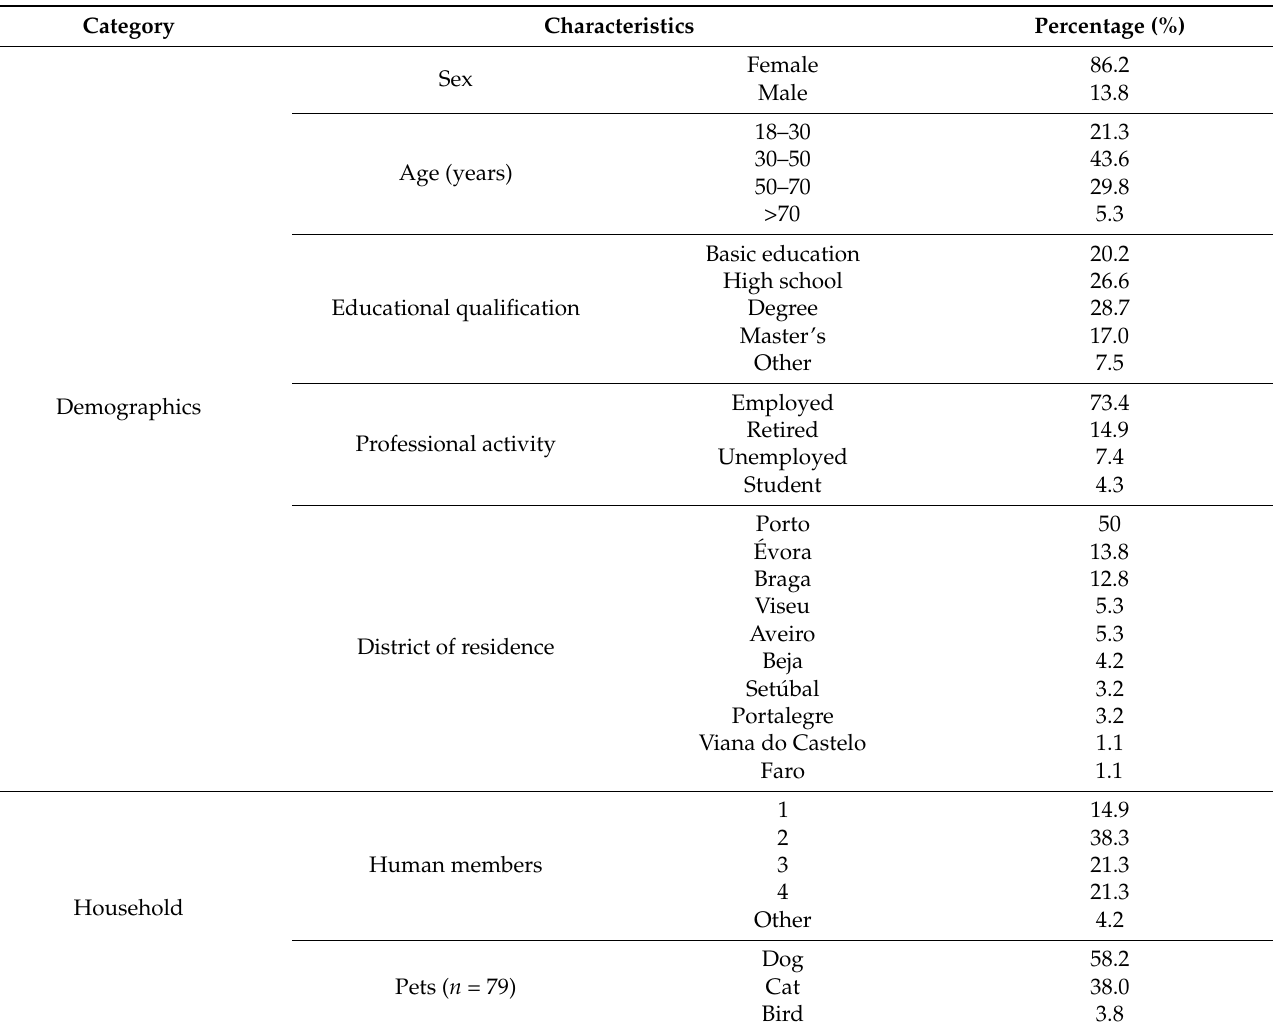
Table 1. Characterization of household, including demographics and household composition ( n = 94; otherwise, n value is